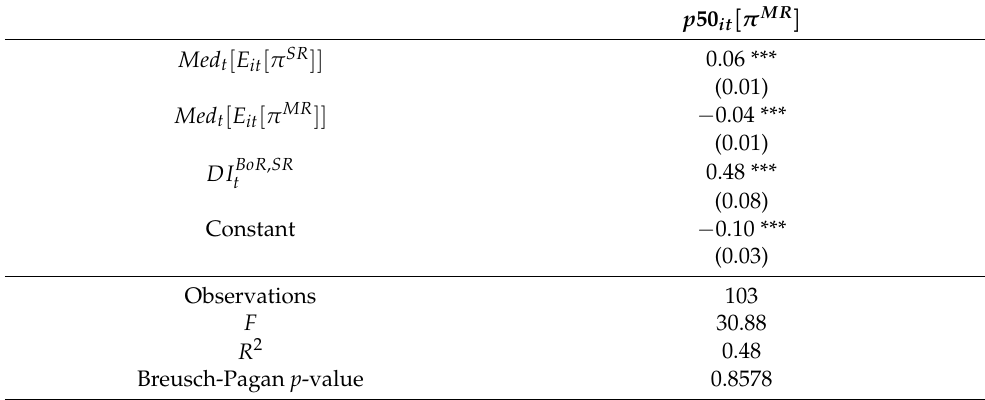
Table 3. The table shows the results from regression Equation (7). The results show that, on average, consumers’ concerns about upside tail risk increase when short run expectations